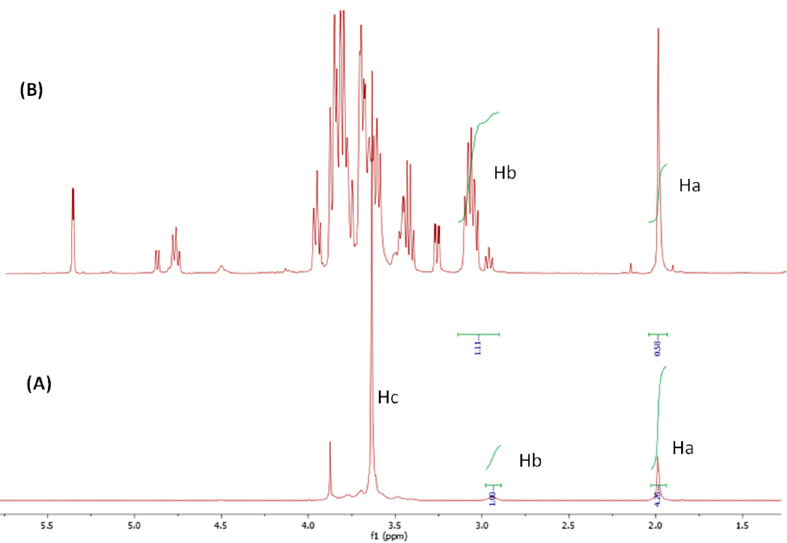
Figure 5. 1 HNMR spectrum of the ( A ) oligosaccharide chitosan nanogels and ( B ) unmodified oligosaccharide chitosan.